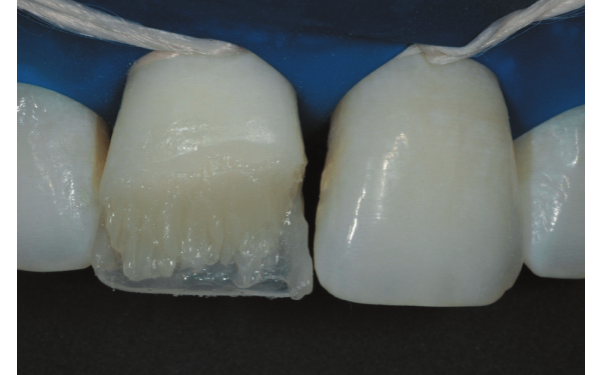
Figure 7- Application of Amaris ® O1 to reproduce a more superficial dentin